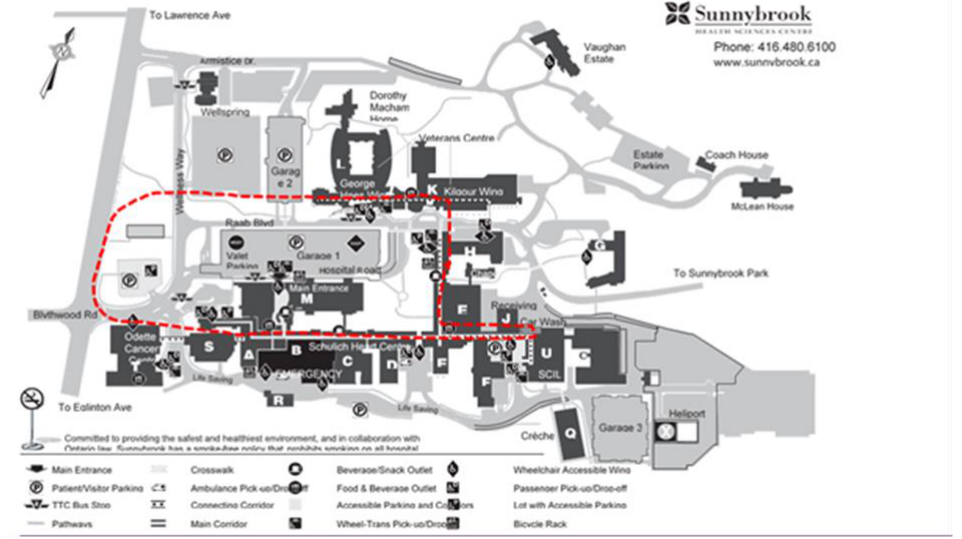
Figure A1. Outdoor Sunnybrook Site Boundaries.